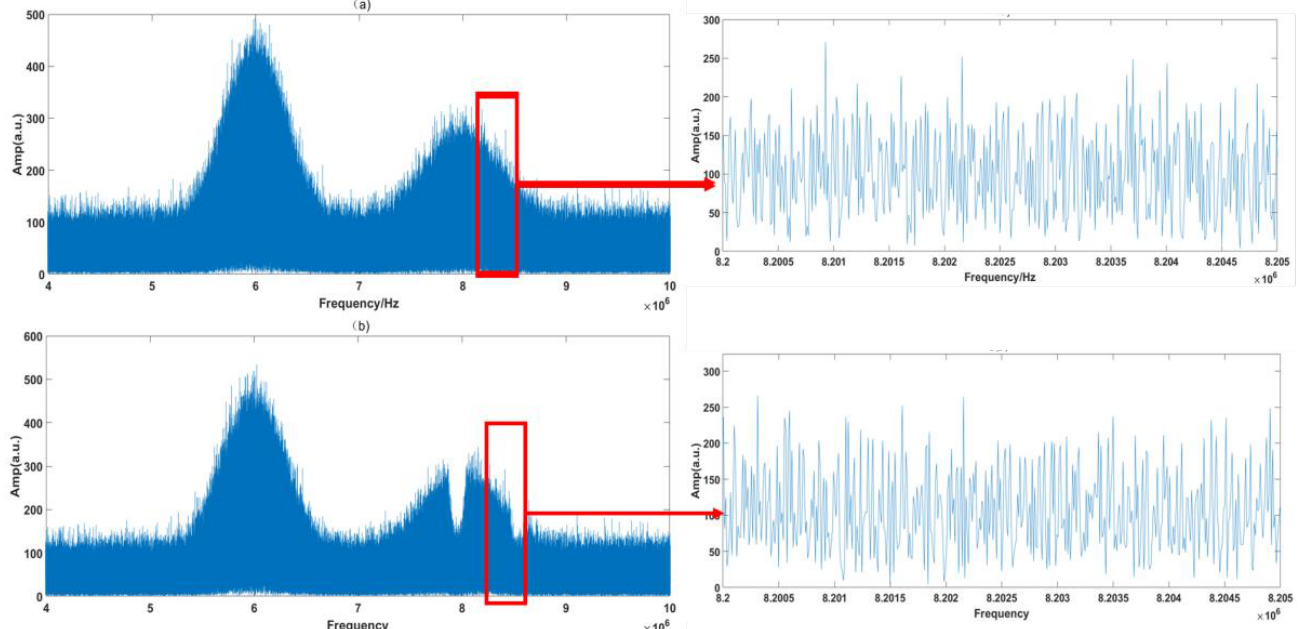
Figure 4. Simulation of the DCS system’s RF spectra with jitters. ( a ) Reference path spectrum, ( b ) signal path spectrum.